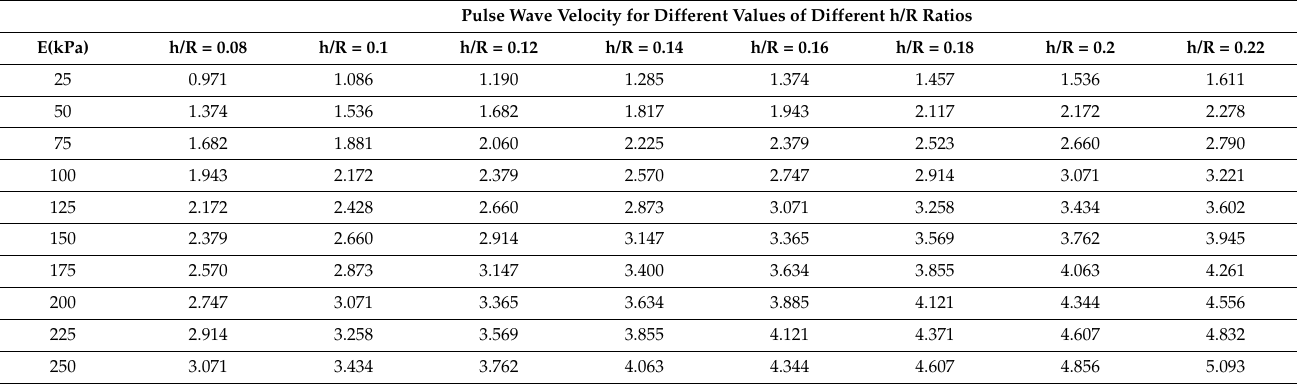
Table 6. Summary of PWV and E estimates for different values of h/r ratios before artery deformation. Pulse Wave Velocity for Different Values of Different h/R